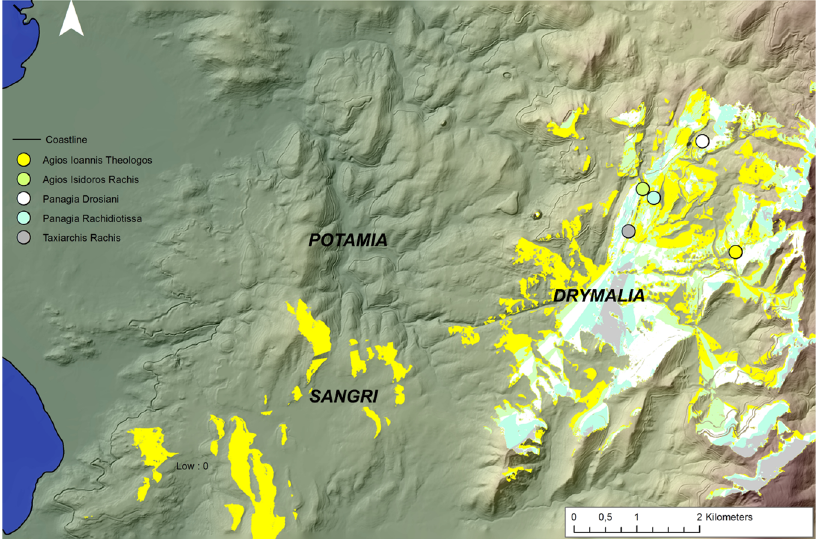
Figure 12: Viewshed analysis from different ‘liminal’ churches on the hills above the valley of Drymalia in Naxos, showing that this network of sacred monuments overlooks the concentration of Byzantine settlements in the valley floor, forming a concep- tual boundary around this rural community (GIS analysis by Vassilis